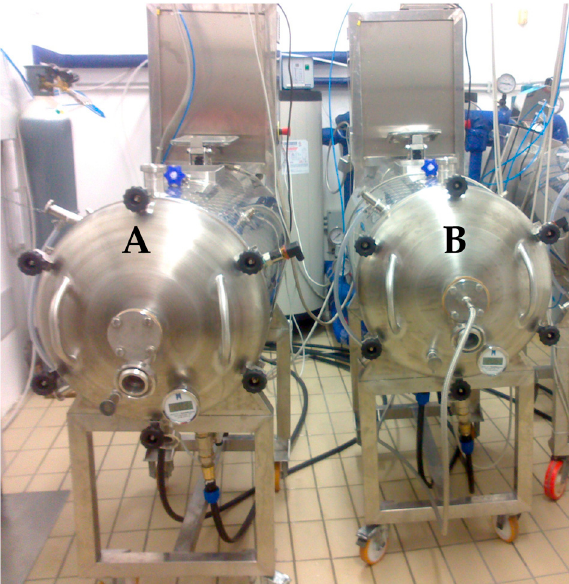
Figure 1. Rotary wine fermenter pilot plants: ( A ) control; ( B ) with ultrasound system.